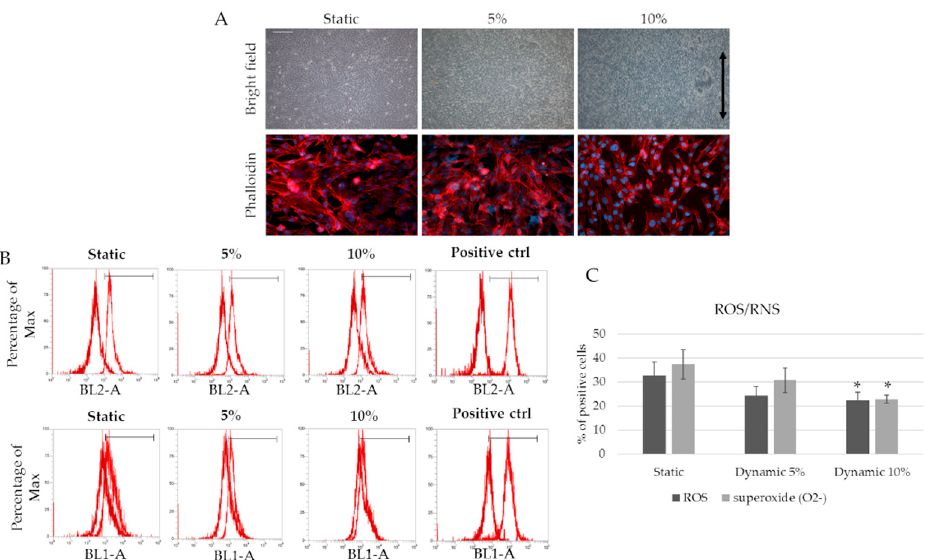
Figure 5. Mechanical strain drives reactive oxygen species (ROS) and reactive nitrogen species (RNS) production. ( A ) EA.hy926 after three days of 5% and 10% strain. Scale bar 200 µm. Phalloidin was used to observe cell morphology. Scale bar 25 µm; ( B ) Fluorescence-activated cell sorting (FACS) analyses for ROS and RNS production. Dark red represents unstained cells, while light red represents the experimental samples. BL2-A for superoxide detection; BL1-A for ROS detection; ( C ) graph of ROS/RNS production * statistically significant with respect to static samples. p < 0.05.